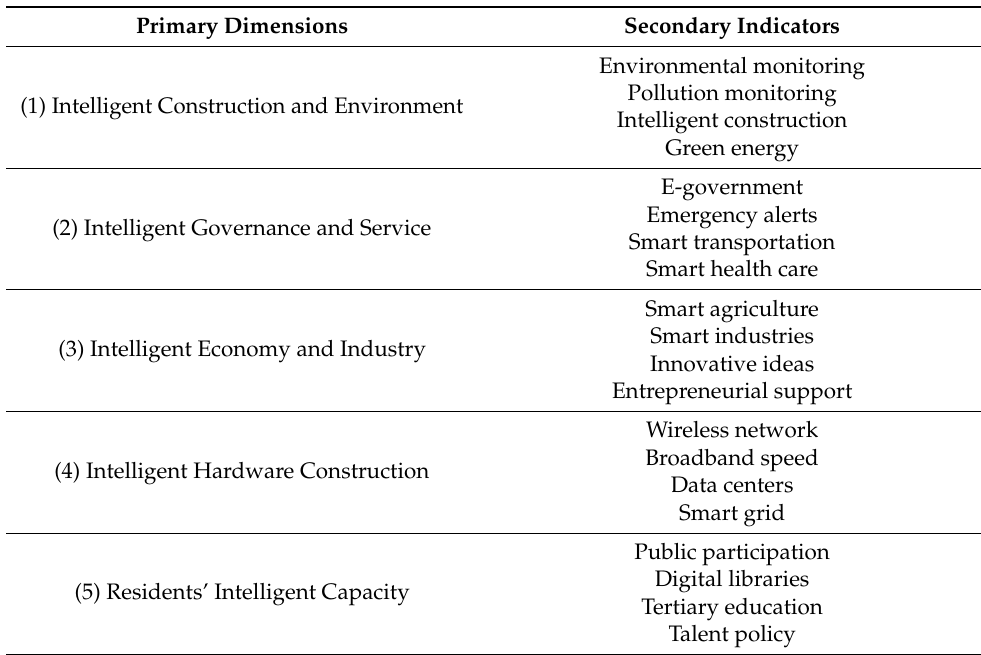
Table 2. The CityIQ evaluation index